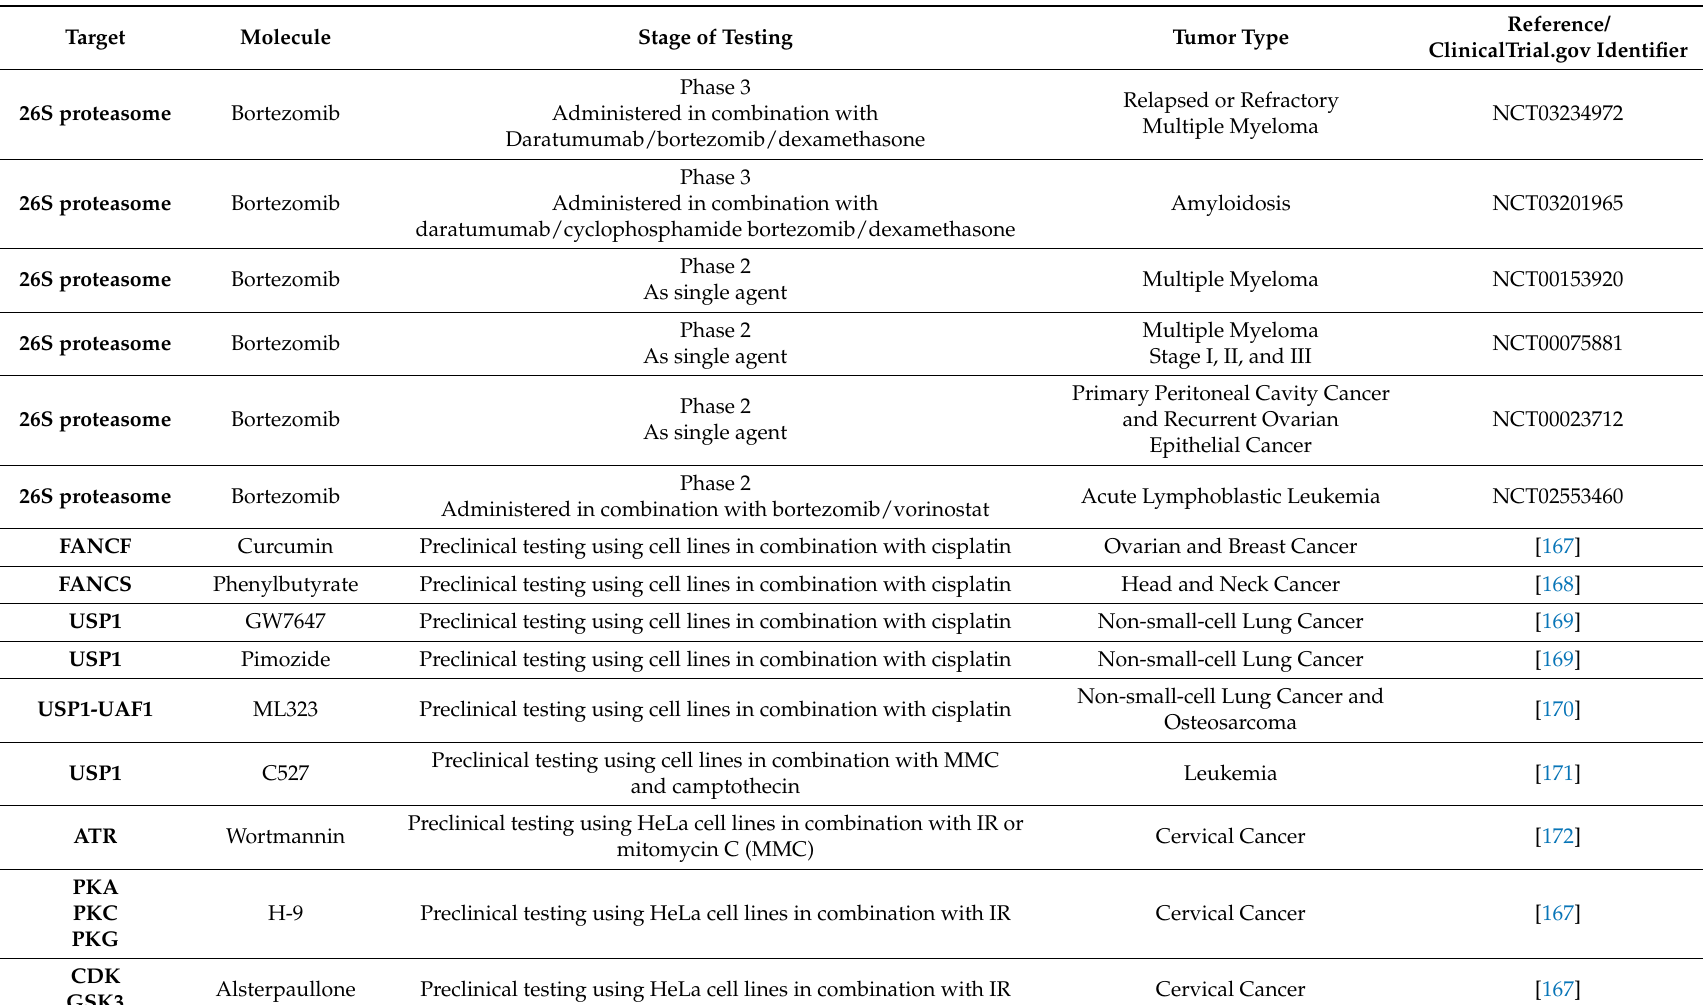
Table 2. Small molecule inhibitors of FANCD2 mono-ubiquitination in preclinical or clinical development for cancer